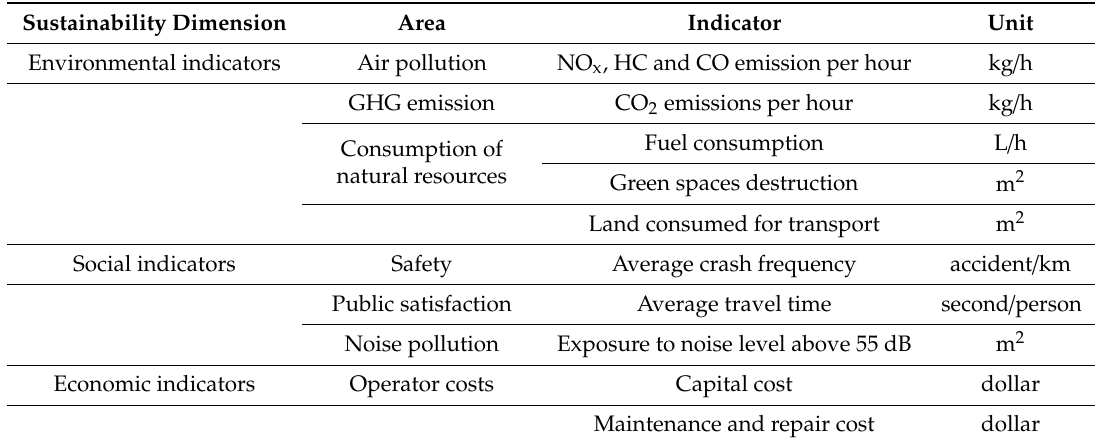
Table 1. Chosen sustainable transportation